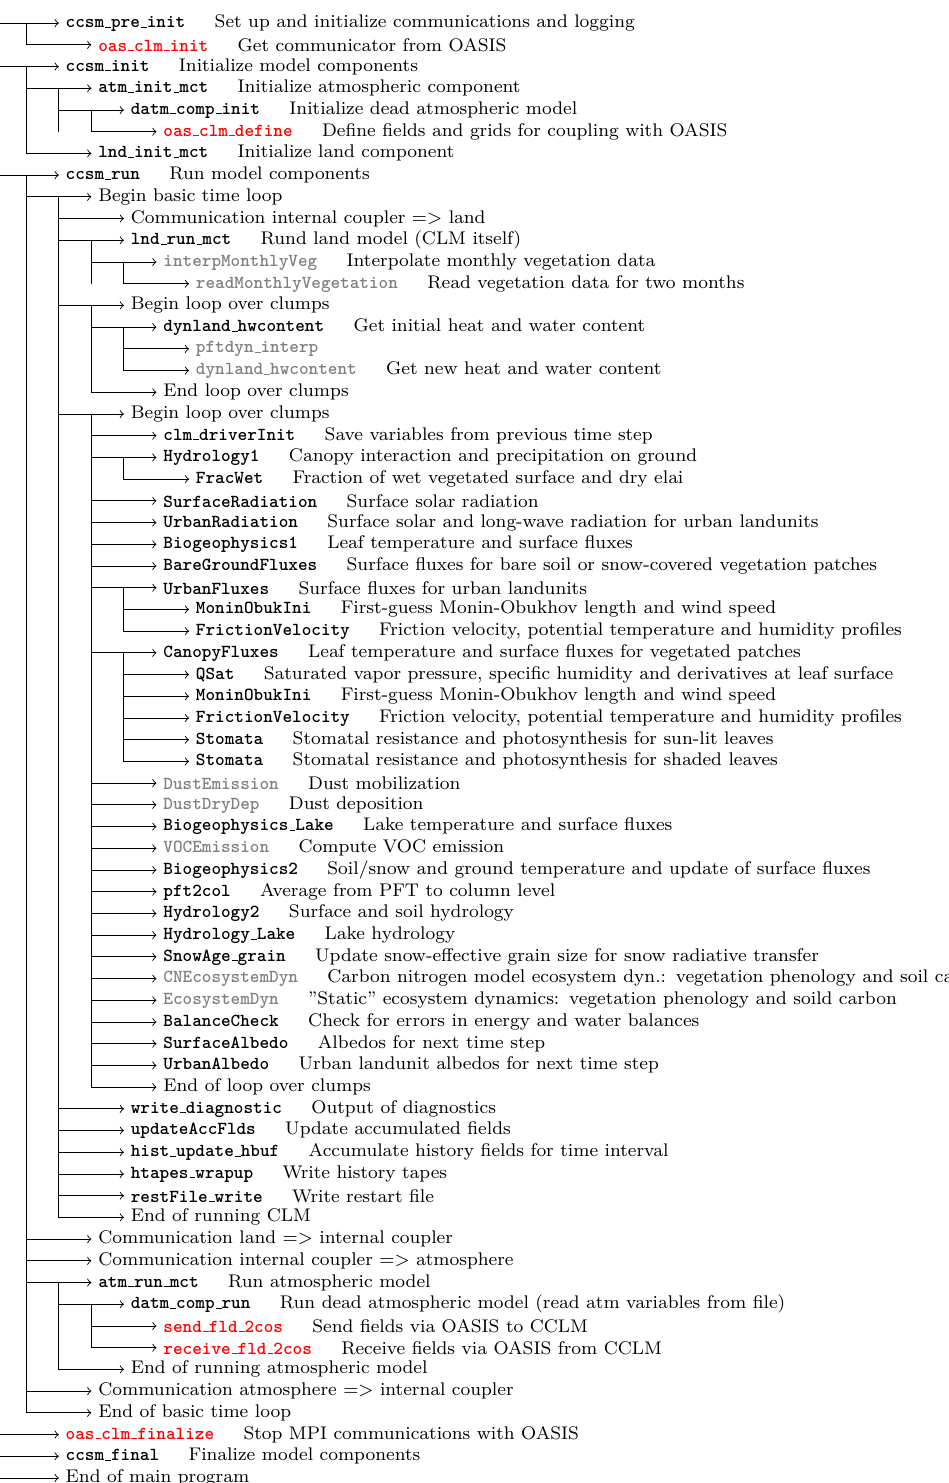
Geosci. Model Dev., 10, 1549–1586,